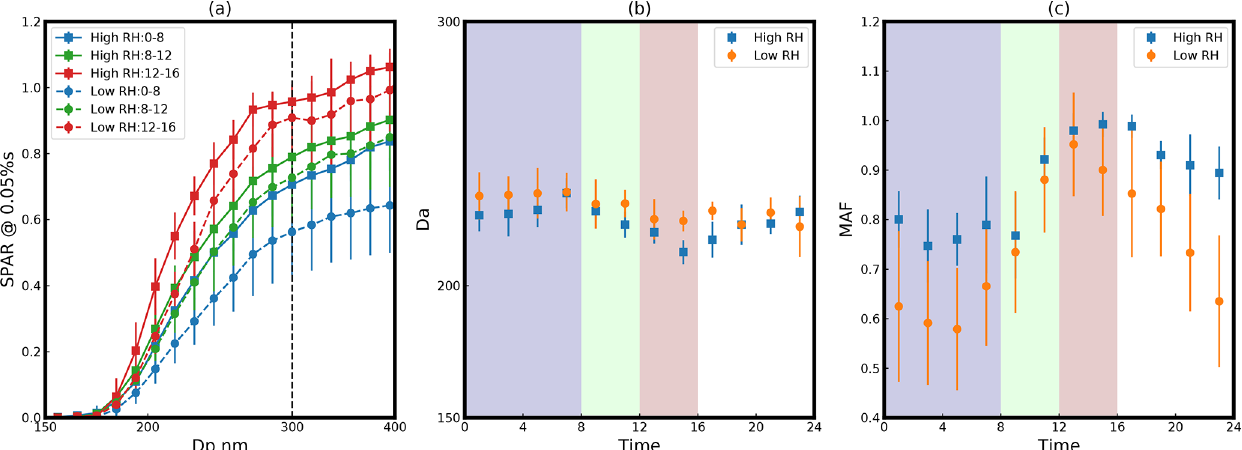
Figure 3. (a) The averages of SPAR curves at SS of 0.05% in three different time periods (blue: 00:00–08:00LT; green: 08:00–12:00LT; red: 12:00–16:00LT) during high (squares with solid line, event 1 and 2) and low (dots with dashed line, event 3 and 4) RH events. Diurnal variation of (b) D a and (c) MAF under high (blue) and low (yellow) RH conditions. The blue, green and red shades correspond to the three periods in panel (a) . Error bars indicate the standard deviations of